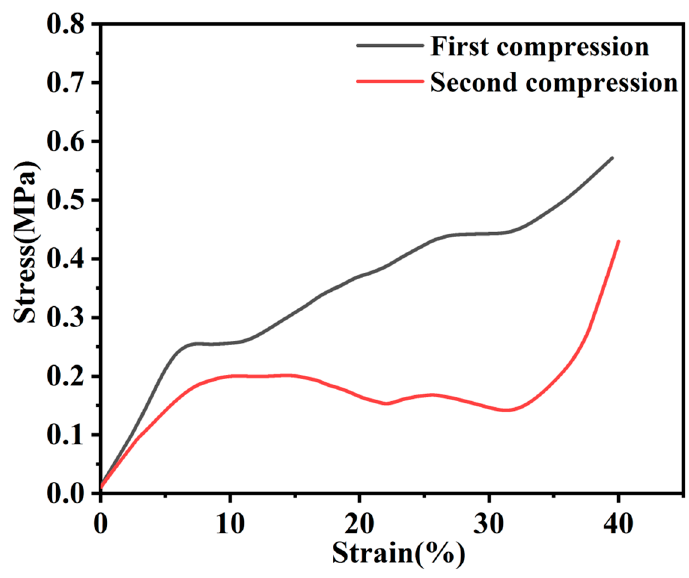
Figure 8. Stress-strain curves of compression for GO-CNT aerogel.